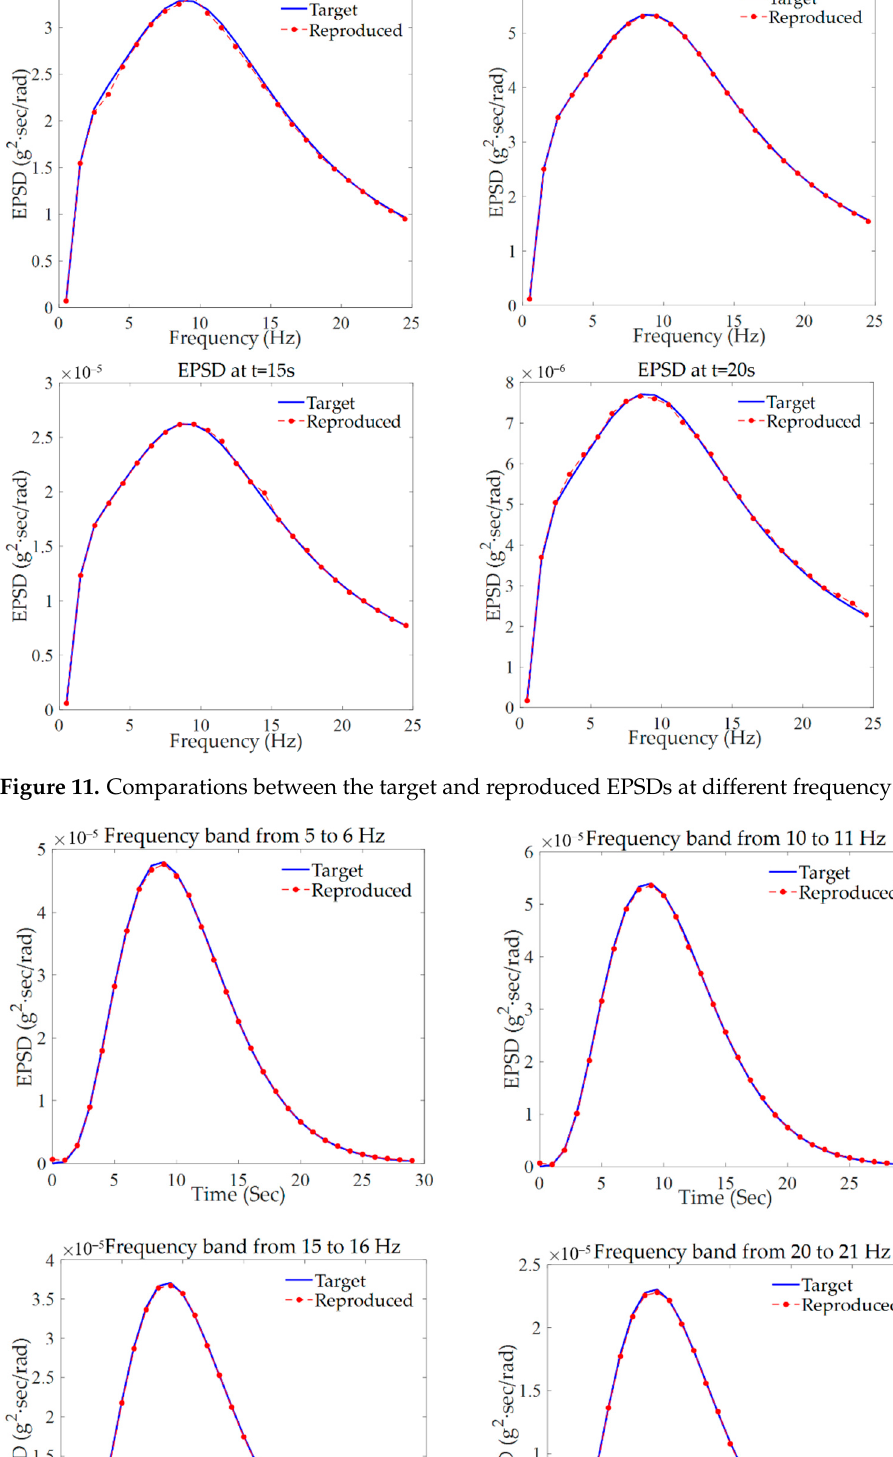
Figure 10. Reproduced EPSD.